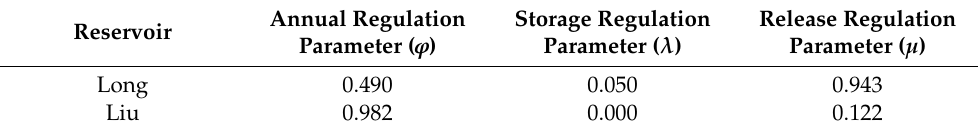
Table 5. Annual, storage and release regulation parameter values of Long and Liu